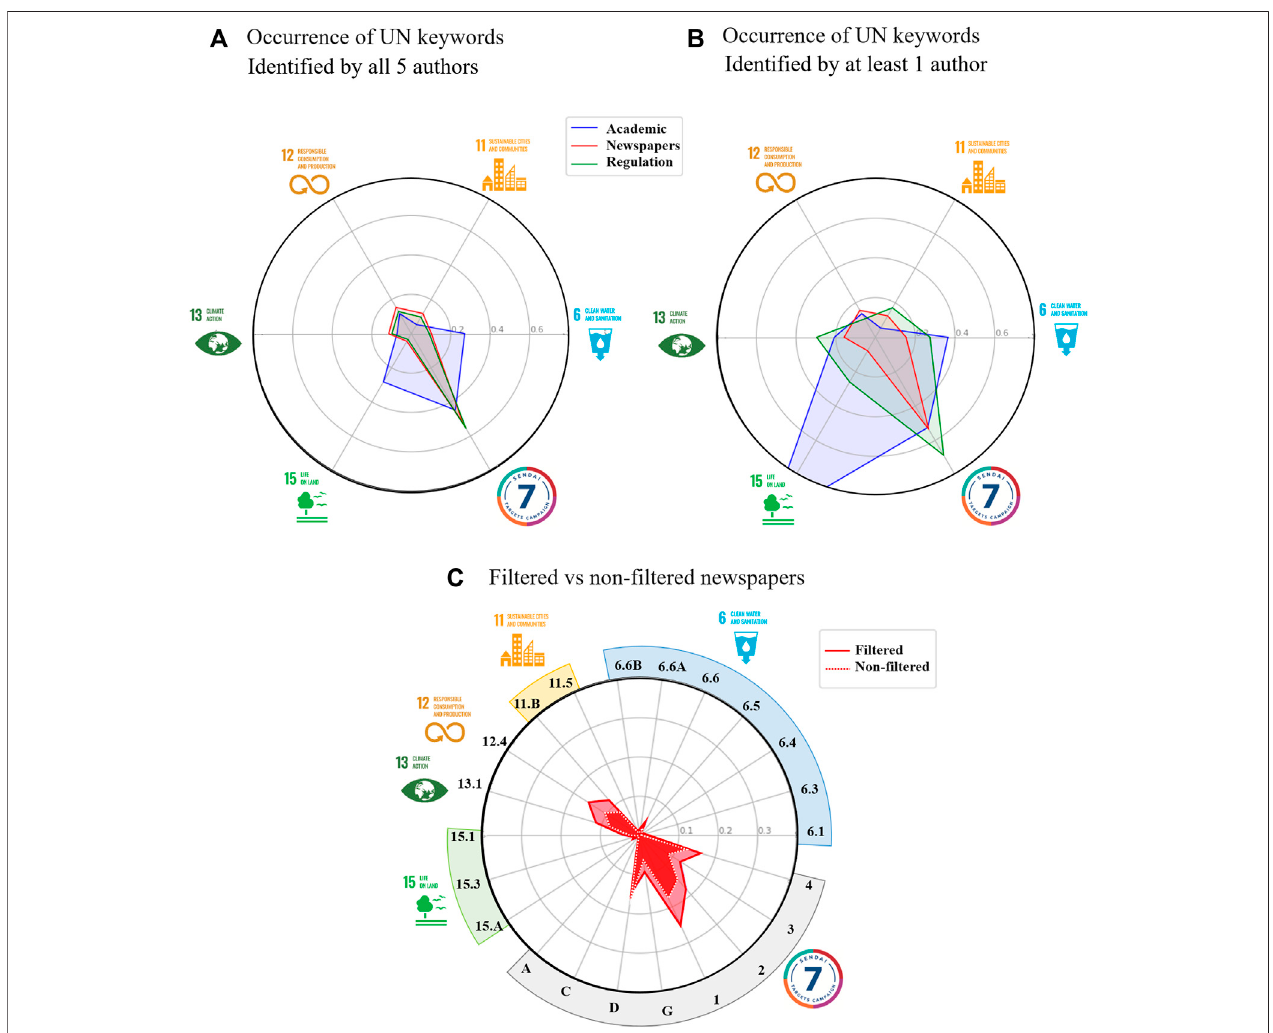
FIGURE 5 | Polar charts showing UN keywords identi fi ed across the academic (blue), newspaper (red) and local regulatory (green) document sources from UN objectives considered relevant (A) by all fi ve authors and (B) by at least one author. (C) Occurrences of UN keywords in fi ltered (solid line) and non- fi ltered (dashed line) newspaperarticlesnormalizedbythetotalnumberofwords in fi lteredand non- fi lterednewspapers (note thatthenumberofwords intheun fi lterednewspapersisabout three times the number of words of the fi ltered newspapers).